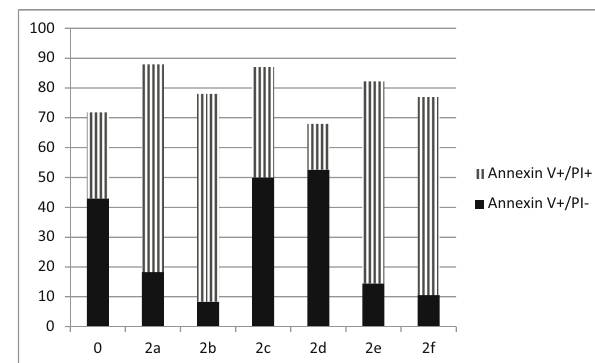
Figure 3: Cell proliferation of the synthesized compound 2a – 2f and untreated cells ( control ) .